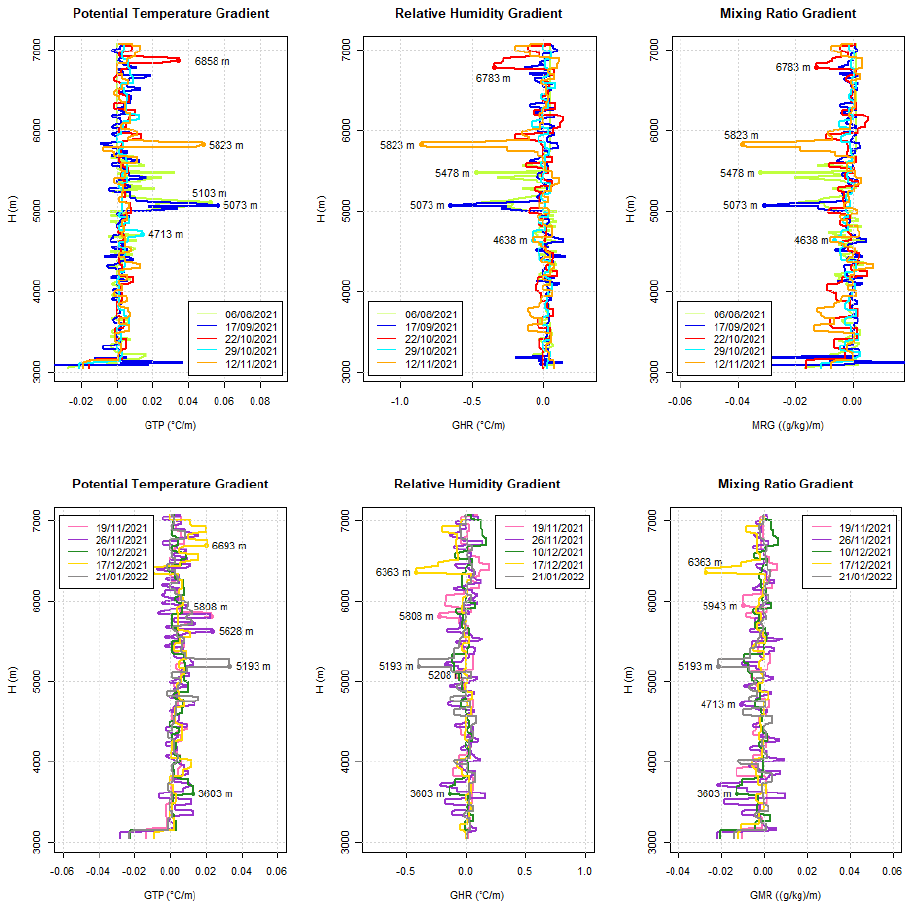
Figure 9. hPBL calculation using three methods: potential temperature gradient, relative humidity gradient, and mixing ratio gradient, for the 10 radiosonde dates, 5 in the graphs above, and 5 in the graphs below. Table 5. Results synthesis of the hPBL calculation at the IZO